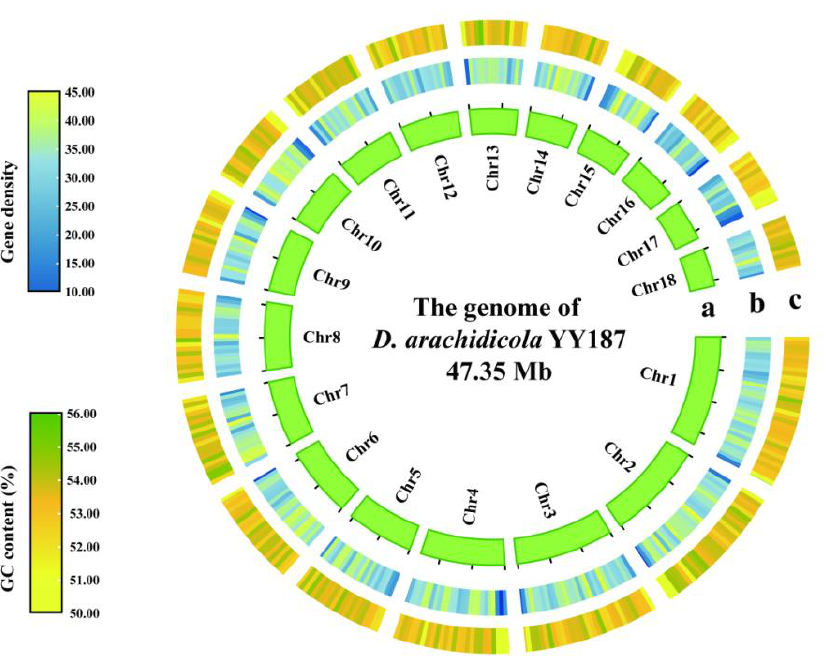
Figure 2. The genomic circos map of D. arachidicola isolate YY187. Circles from inside to outside are (a) chromosome information of the D. arachidicola genome (scale marks in Mb). (b) Gene density on different chromosomes, color-coded from blue to yellow, represents values from low to high. (c) GC content, color-coded from yellow to green, represents values from low to high. Visualization was performed using advanced circos in TBtools v1.098769.